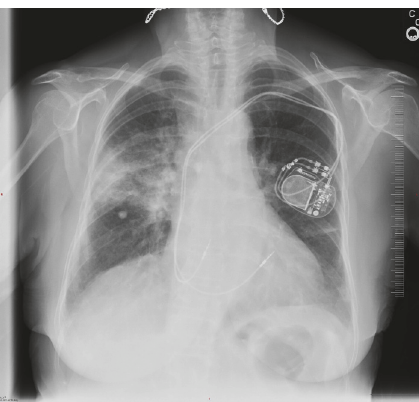
Figure 3: A chestX-ray showing the developmentof lung infiltrates in and around the treated rightlung mass occurring one month following completion of SBRT.